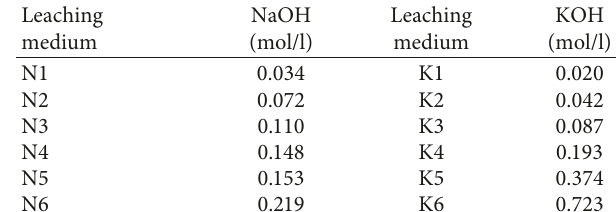
Table 3: Composition of the basic leaching solutions and their designation.